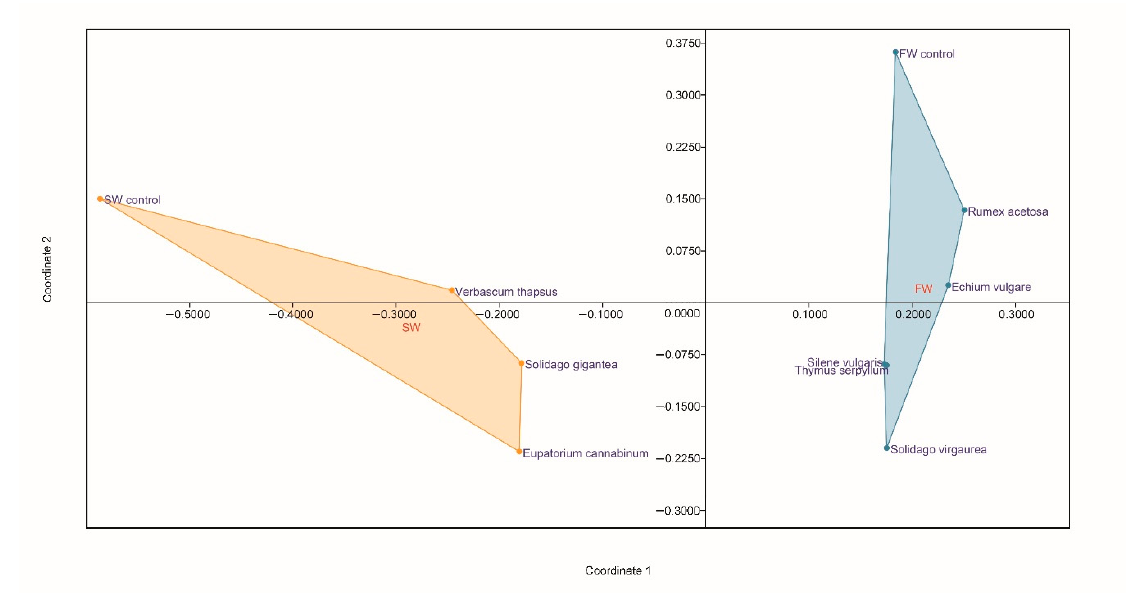
Figure 6. Non-metric multidimensional scaling (NMDS) for the microbial community structure in FW and SW